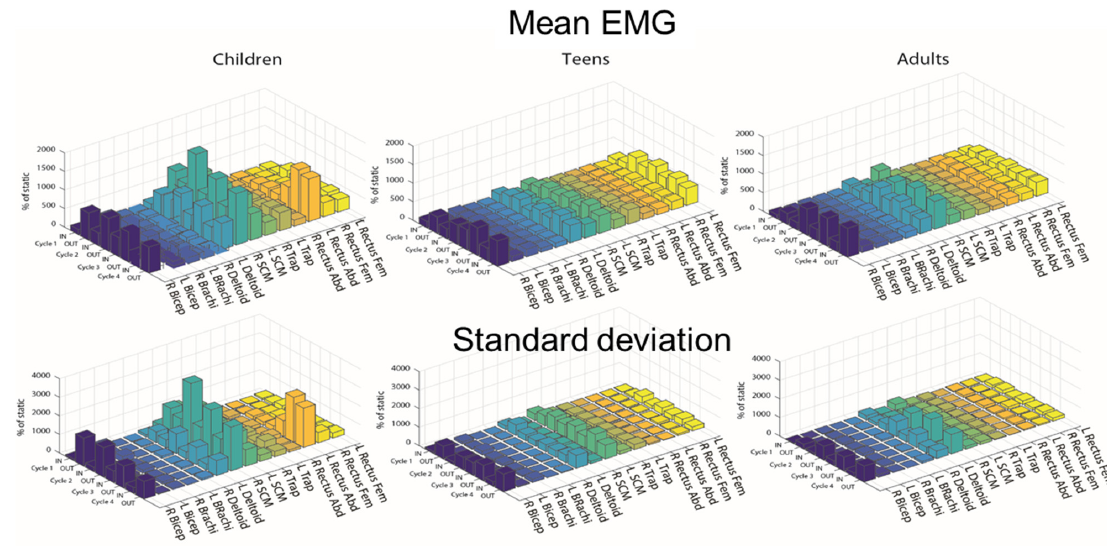
Figure 4. Mean and SD of normalized to static trial Mean EMG calculated for each cycle and age group and expressed as a percentage of muscle activation in the static trial. SCM: sternocleidomastoids; EMG: electromyography.